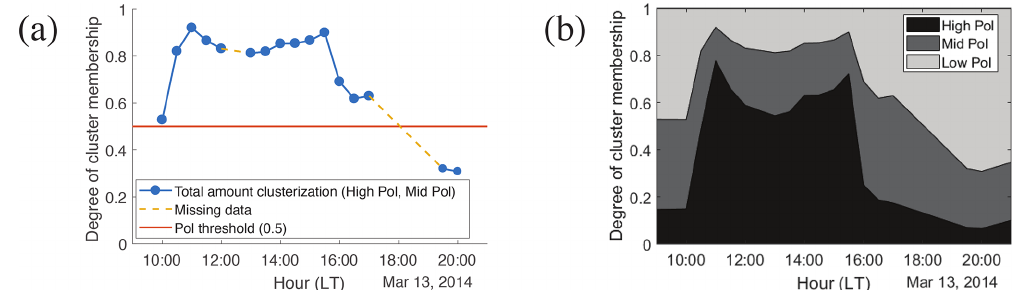
Figure 3. Results of FCM clusters analysis during 13 March 2014 from 10:00 to 20:00LT (local time) at the T3 site. (a) Total clustering, considering polluted conditions with the degree of cluster membership > 0 . 5. (b) Degree of membership in each of the three clusters. The sum of the degrees of membership across all clusters is unity. Background conditions are abbreviated as low pol, intermediate conditions as mid pol and polluted conditions as high